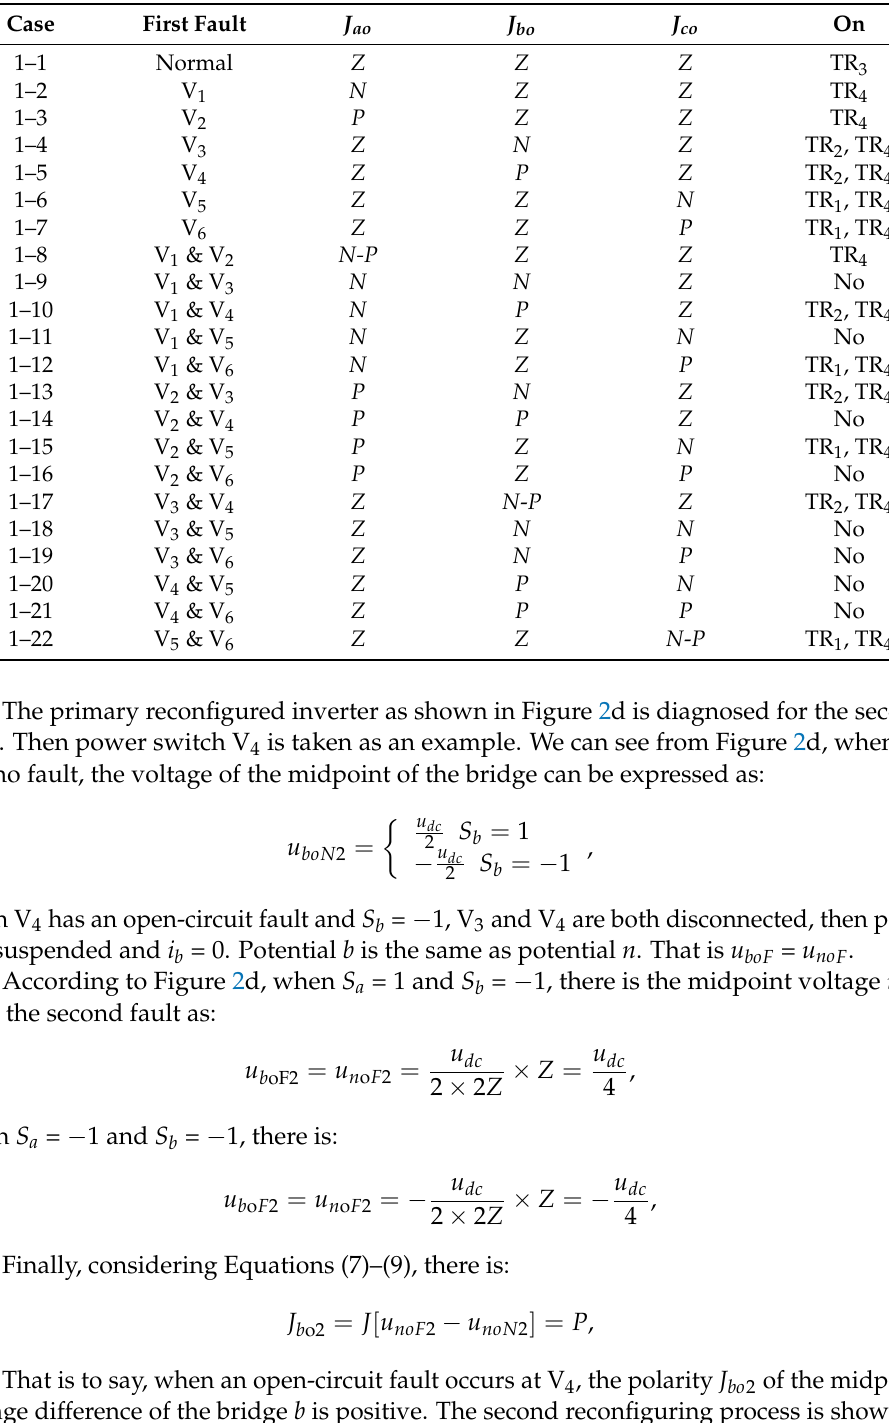
Table 2. First fault diagnosis and